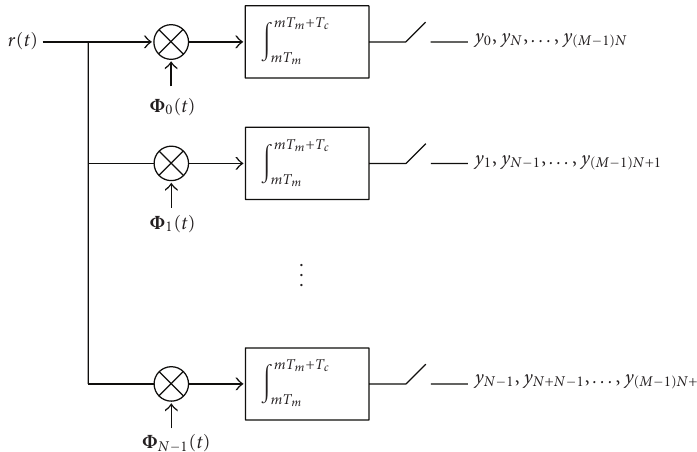
Figure 2: Block diagram of the parallel segmented compressive sensing (PSCS) architecture.